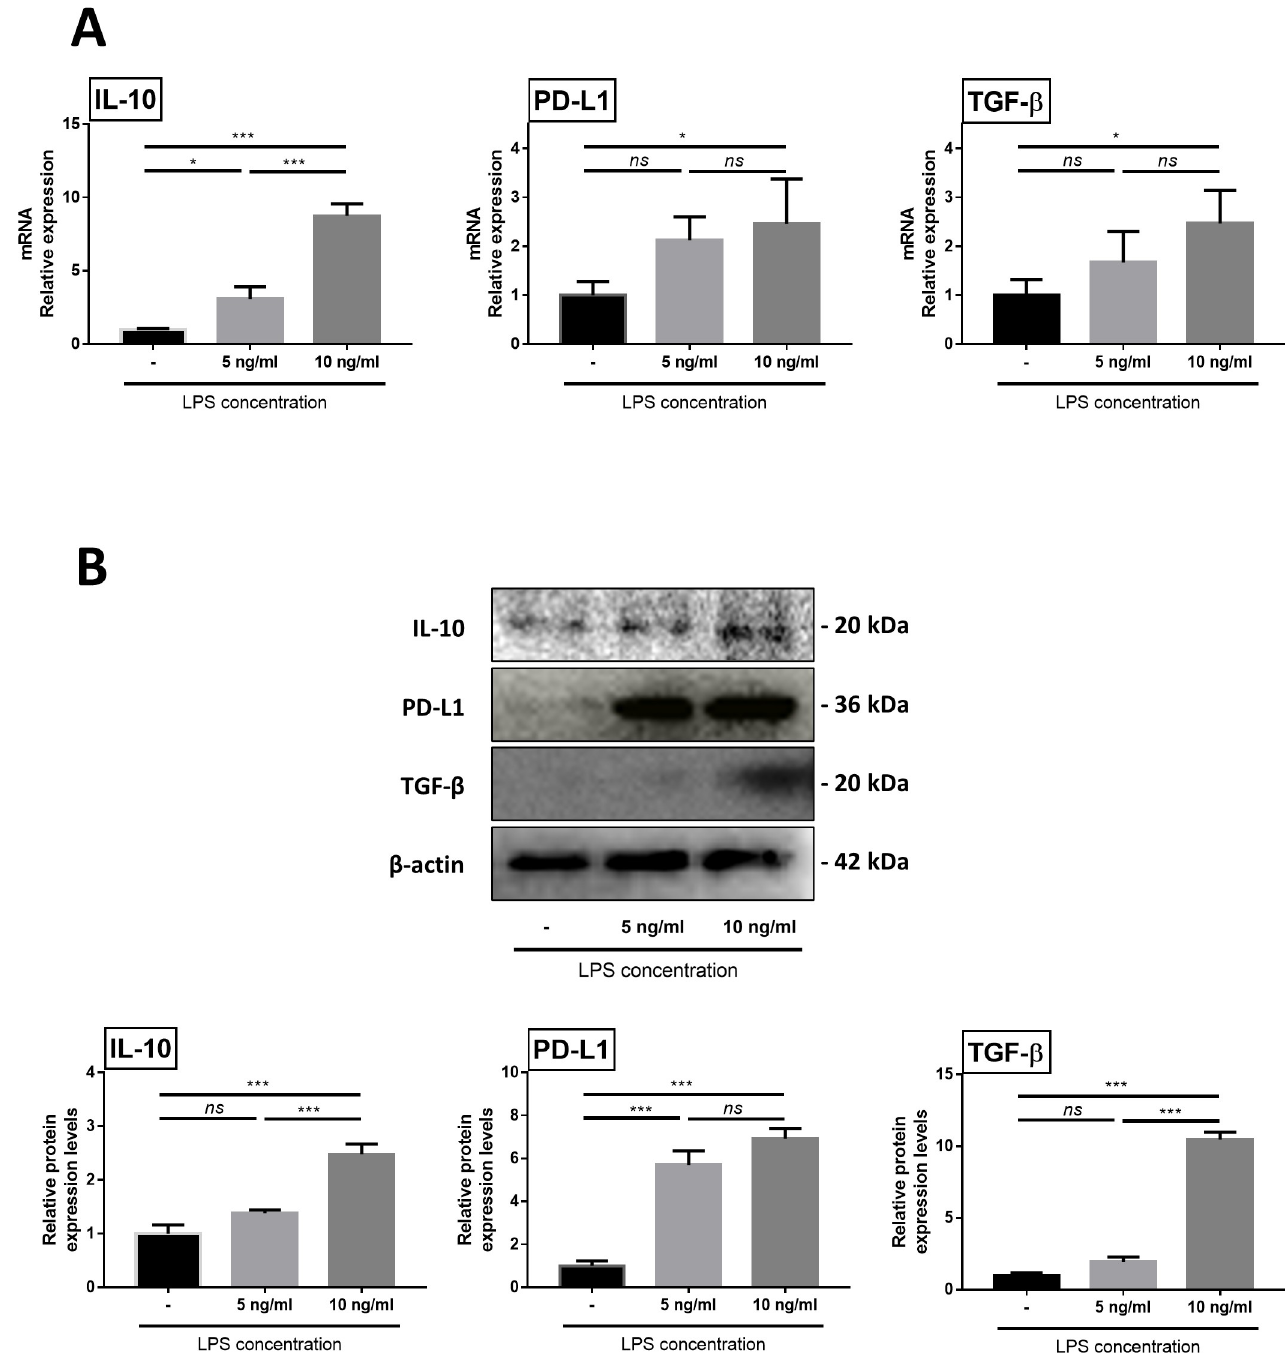
Fig 2. Expression of immunoregulatory factor. (A) Increased gene expression of IL-10, PD-L1 and TGF- β in primed B cells. (B) Increased protein expression of IL-10, PD-L1 and TGF- β in primed B cells. Results are presented as the mean ± standard deviation of three independent experiments. Data are shown as mean ± standard deviation of three independent experiments ( ns = Not Statistically Significant, � P < 0.05, �� P < 0.01, ��� P < 0.001 by one-way ANOVA analysis).